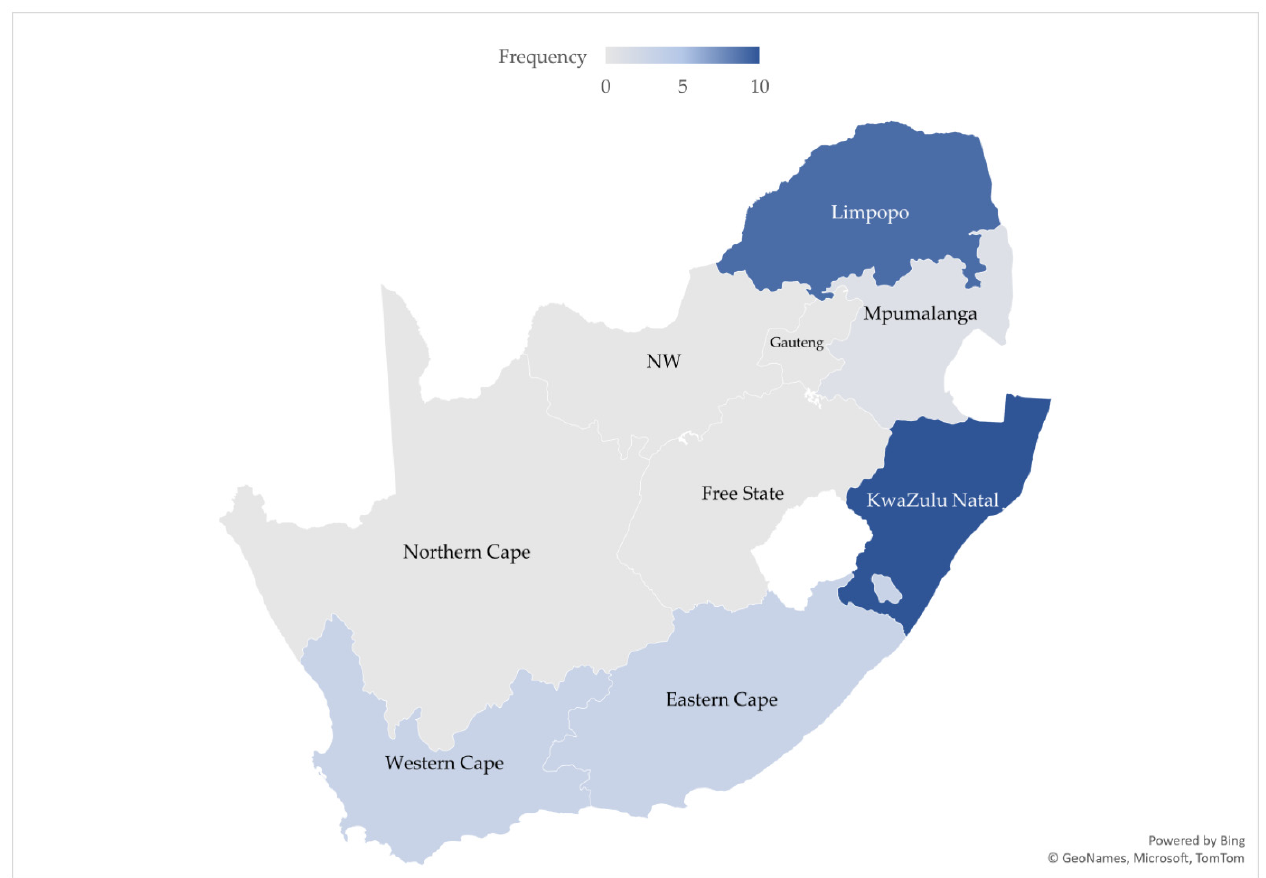
Figure 2. Spatial coverage of climate change vulnerability research in South Africa. Source: Authors’ analysis derived from the literature sources included in the review.